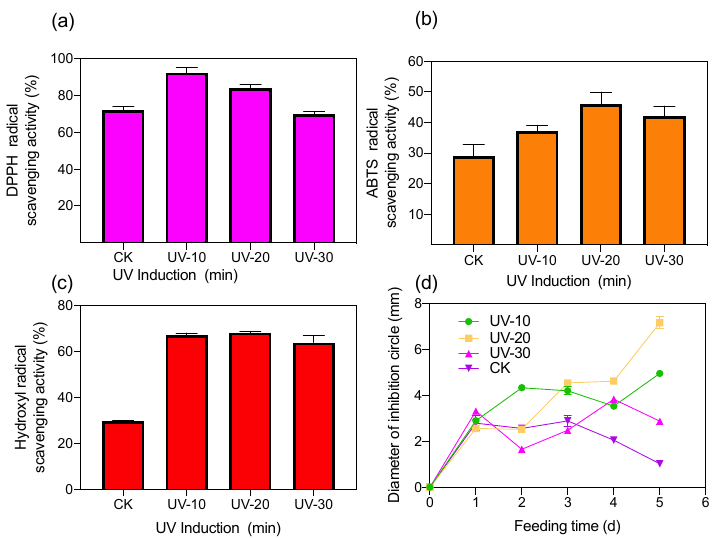
Figure 2. Comparison of antioxidant and antibacterial properties of UV-induced insect powder ex- tracts from BSF feeding on food waste ( a ) DPPH, ( b ) ABTS, ( c ) Hydroxyl radicals, and ( d ) Antibacterial properties ( p < 0.05).